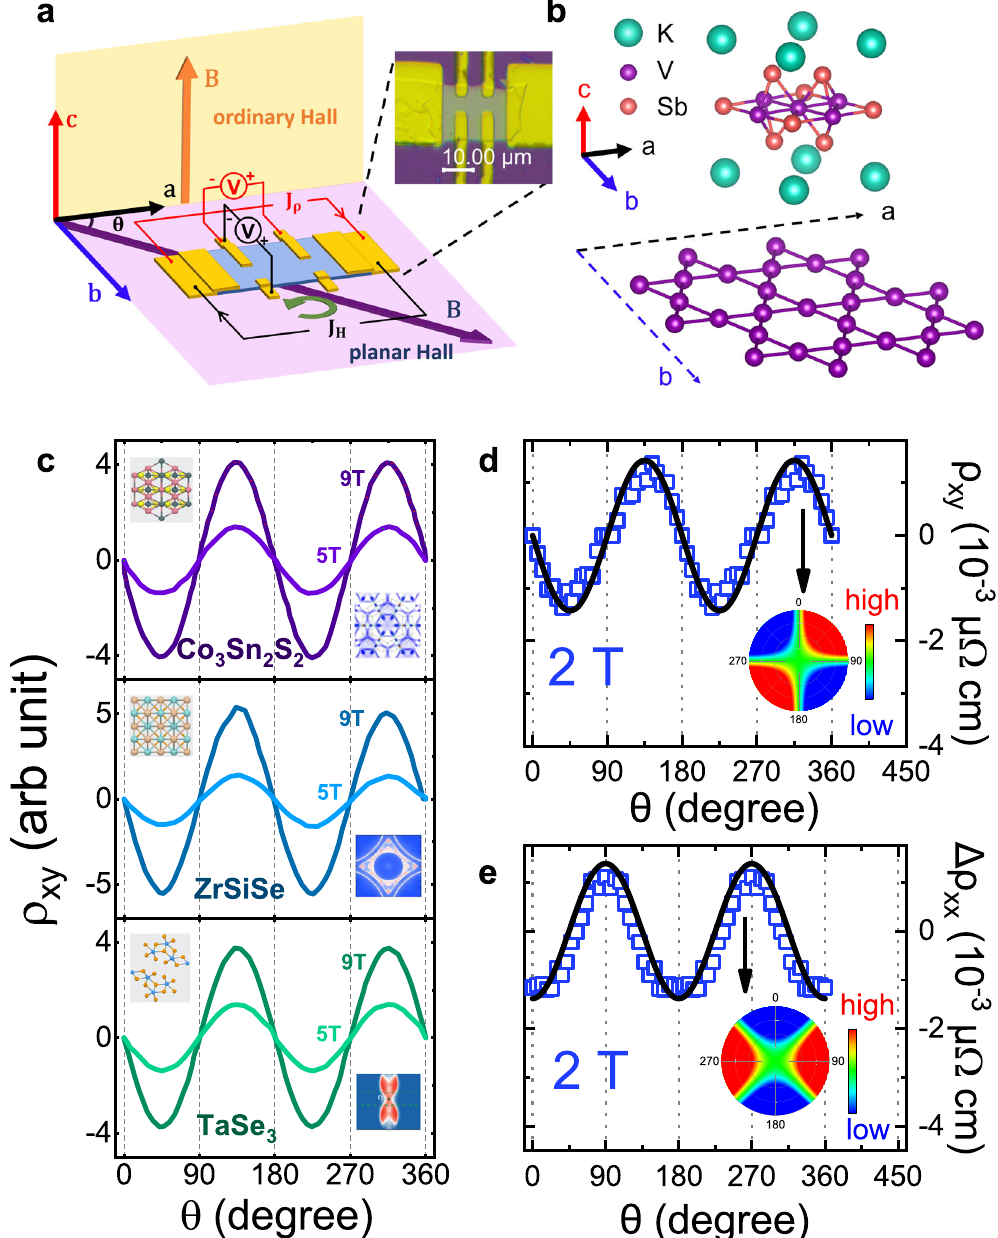
Fig. 1 Schematics and typical results of the measurements for PHE and PAMR. a Schematic of the geometry of the device in our measurements for the ordinary Hall, planar Hall, and longitudinal resistivity. Inset: the picture of our device. b Crystal structure of KV 3 Sb 5 . θ is de fi ned as the angle between the directions of current and in-plane applied fi eld. For our device, the current is along a axis. c The PHE in Co 3 Sn 2 S 2 , ZrSiSe, and TaSe 332 – 37 . The insets: the crystal structure and Fermi surface in these three materials. d , e ρ xy ( θ ) and ρ xx ( θ ) with μ 0 H = 2 T at 10 K marked by blue open squares. The black solid lines indicate the ρ xy ( θ ) and ρ xx ( θ ) for conventional PHE and PAMR described by formula 1 and 2 respectively, which are also plotted in the insets exhibiting two-fold symmetry by the color contours in polar coordinates where the r axes are ρ xy ( θ ) and ρ xx ( θ ) respectively, and θ is the rotating angle de fi ned in ( a conventional angular dependence. The little discrepancy between our results and empirical formulas can be attributed to the existence of additional higher-order oscillations (discussed below). Fig. 1d, e 32 – 37 . It is observed the anisotropy from lattice, magnetism, or Fermi surface, etc usually hardly affect the in- plane transport behavior such as PHE and PAMR. For KV 3 Sb 5 , obvious PHE and PAMR are observed at 2 K even with a small applied fi eld of μ 0 H = 2 T after subtracting the OHE and out-of- plane magneto resistivity 9,13 . ρ xy and ρ xx (shown in Fig. 1d, e) exhibit two-fold symmetrical oscillations and roughly follow the